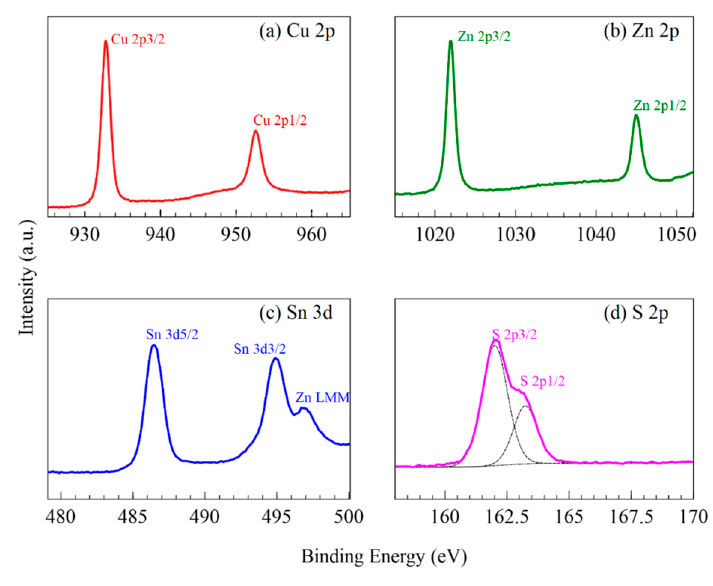
Figure 3. XPS high resolution spectra of CZTS thin films of ( a ) Cu 2p, ( b ) Zn 2p, ( c ) Sn 3d, and ( d ) S 2p.